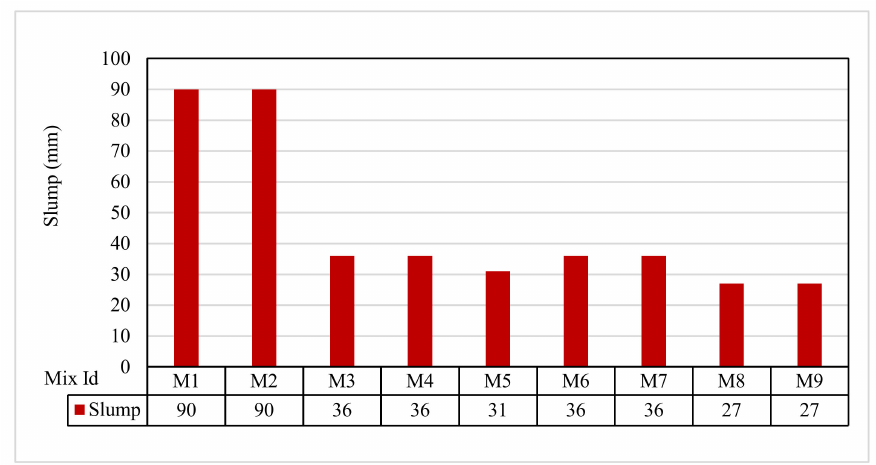
Figure 5. The slump test results.